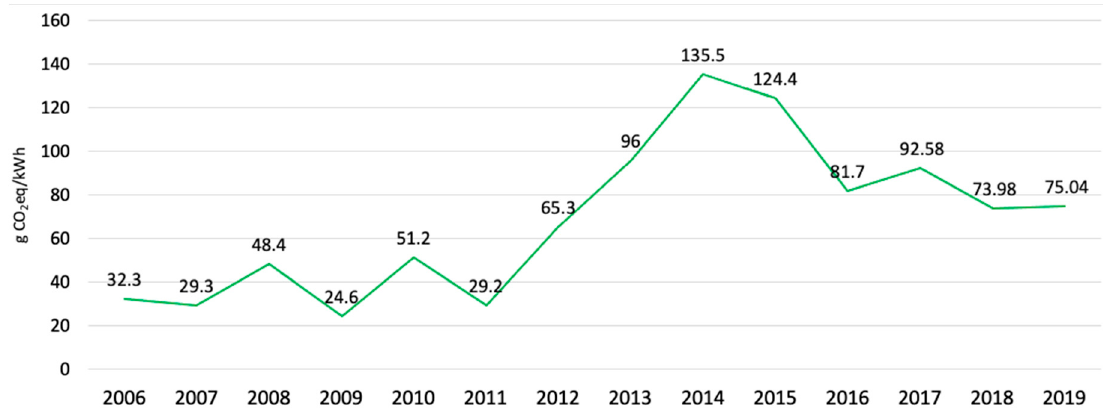
Figure 5. Evolution of Brazilian electricity emission factors in g CO2/kWh (2006–2019). Data Source [11].